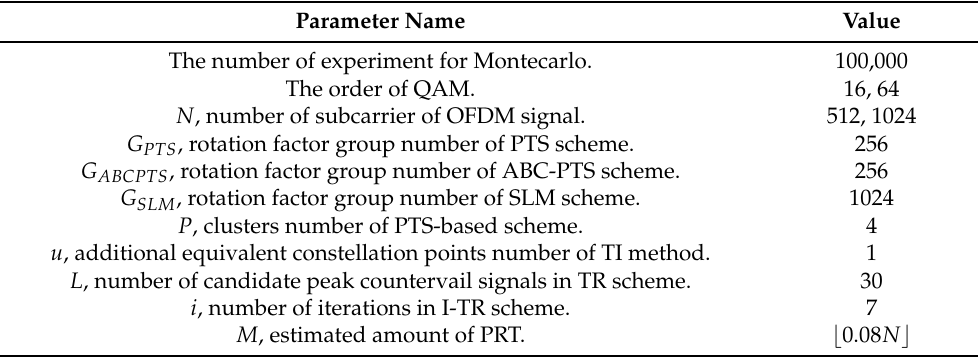
Table 2. Simulation scenario and related